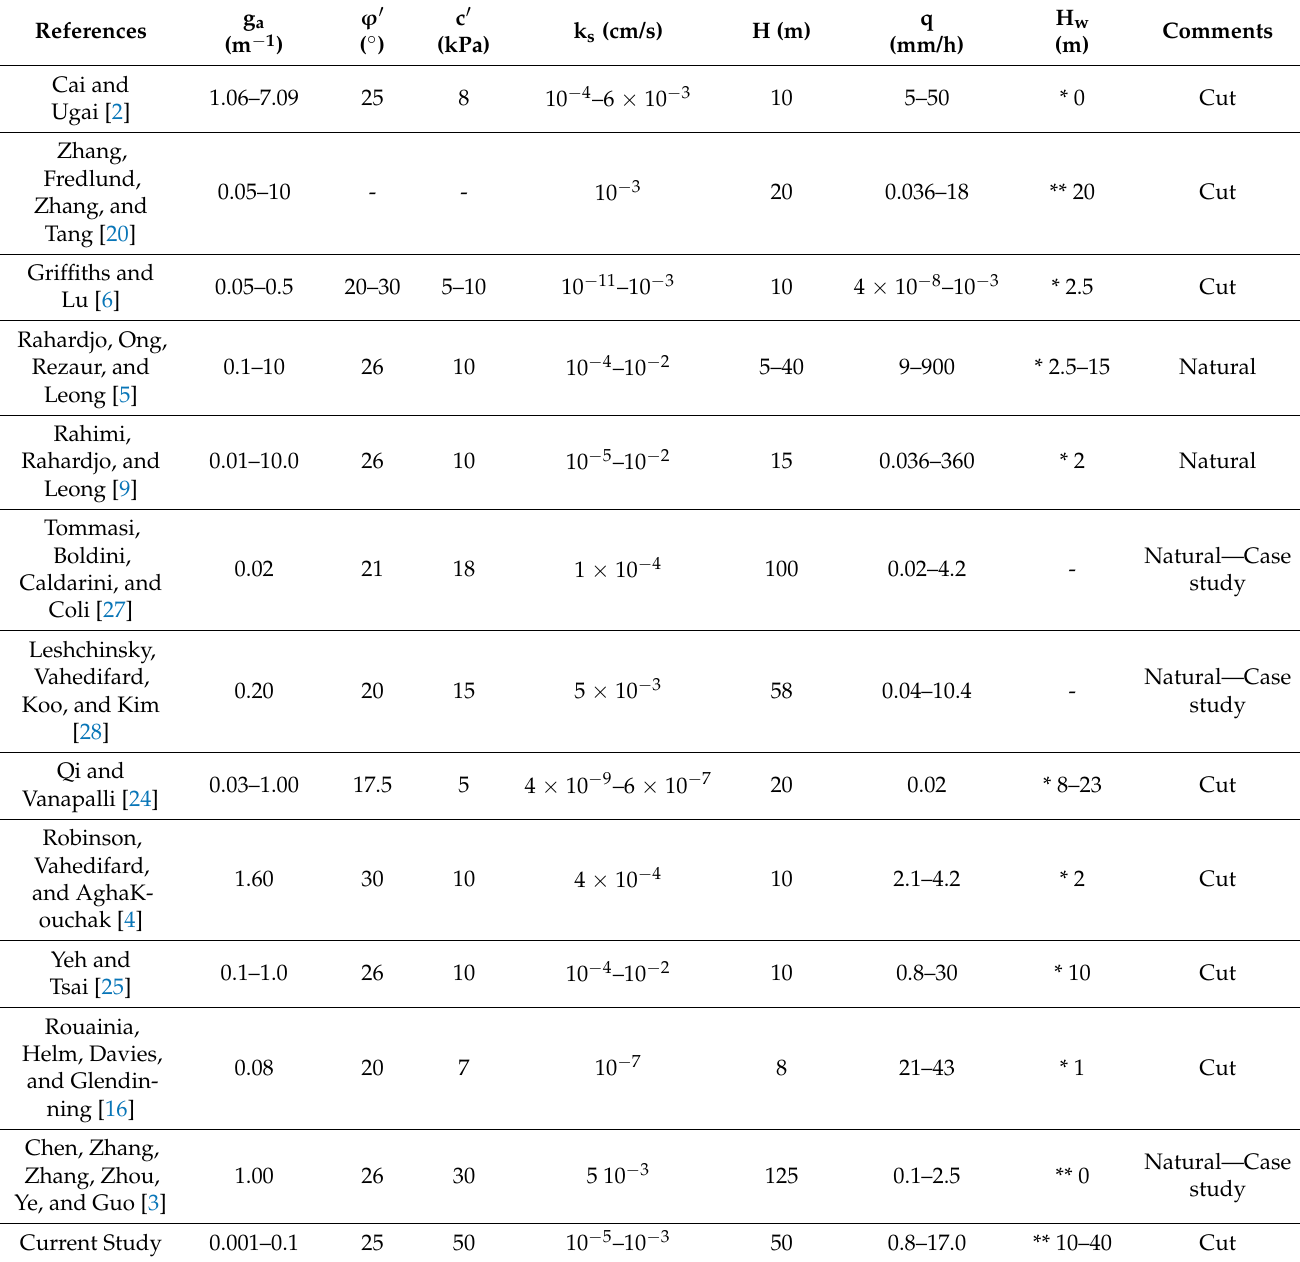
Table 1. Basic parameters of previous characteristic